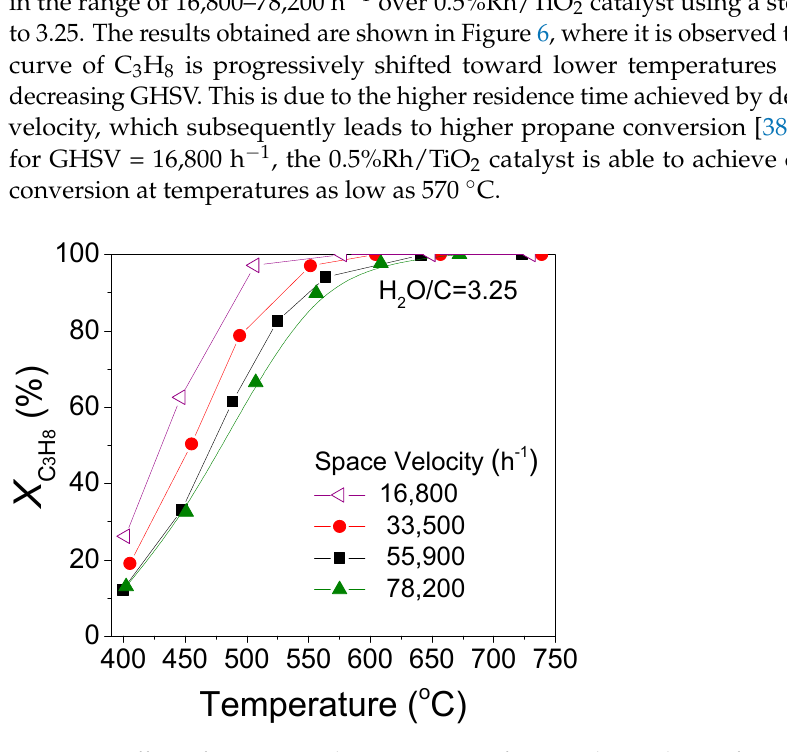
Figure 6. Effect of GHSV on the conversion of C 3 H 8 obtained as a function of reaction temperature over 0.5%Rh/TiO 2 catalyst. Experimental conditions: H 2 O/C:3.25; particle diameter: 0.15 < d p < 0.25 mm; feed composition: 4.5% C 3 Η 8 , 0.15% Ar, 44% H 2 O (balance He).